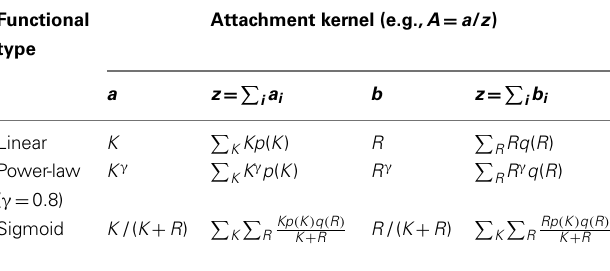
Table 1 | Normalized attachment kernels used to create the model